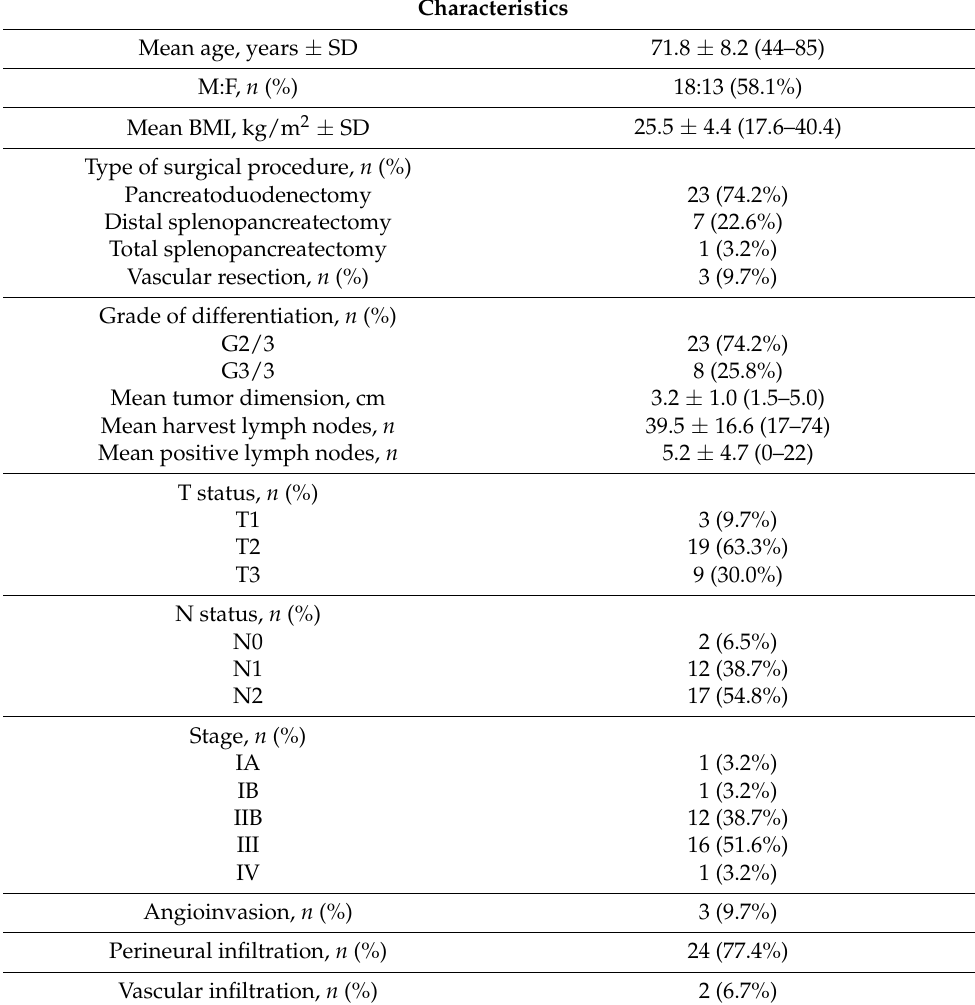
Table 1. Characteristics of the PDAC patients enrolled ( n =